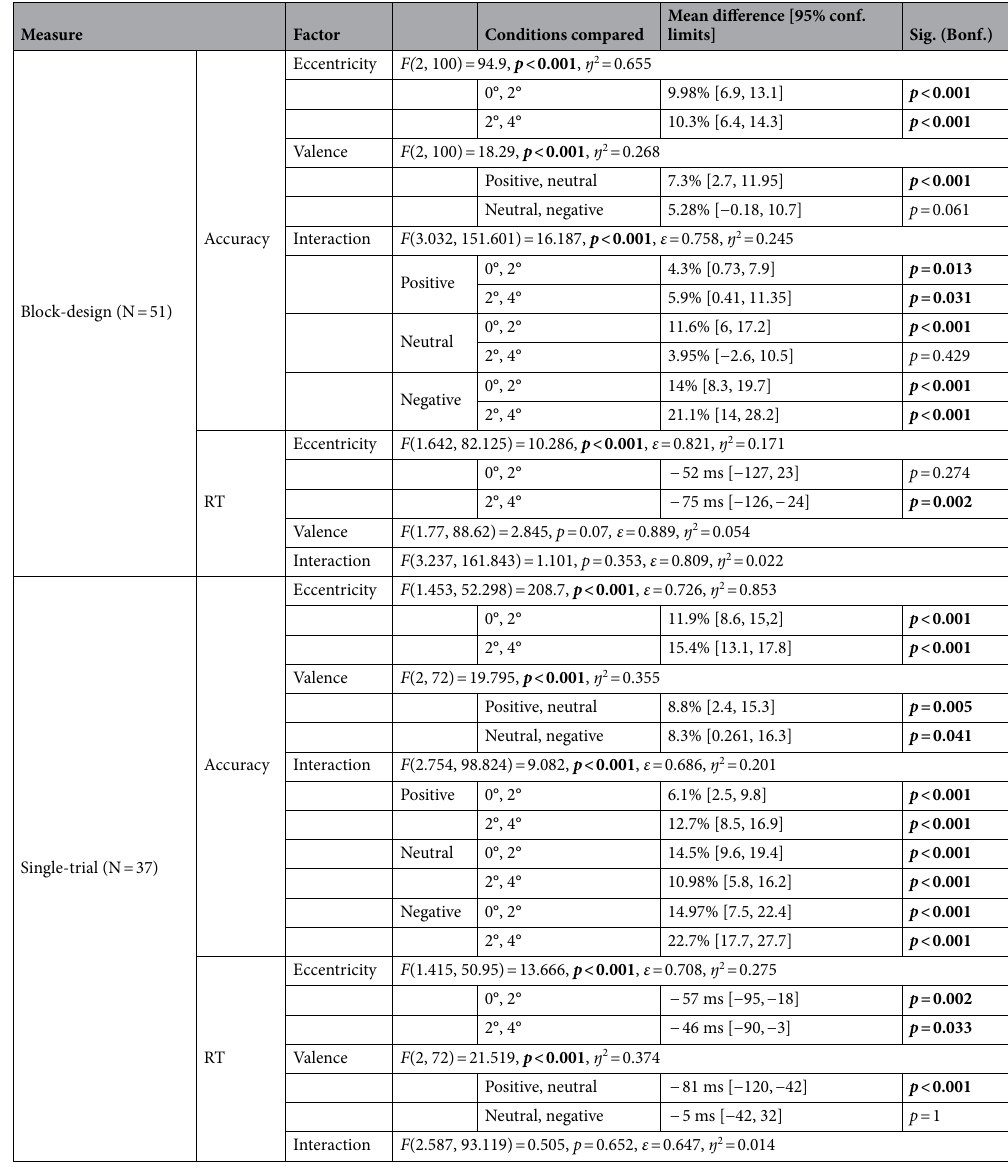
Table 2. Statistical analyses summary per experiment. For each experiment results of two 2-way repeated- measures ANOVAs (3 × 3) measuring the effects of eccentricity (0°, 2°, 4°) and valence (positive/neutral/ negative) on accuracy or RTs (post-hoc analyses based on Bonferroni corrections). Mean difference and 95% confidence interval [lower bound, upper bound] in Mean difference column. Significant results in bold. As can be seen significant effects of eccentricity and valence on accuracy were found in both experiments as well as a significant interaction between them). Eccentricity significantly affected RT in both experiments, but valence only in the single-trial experiment with faster responses for positive valence. See also Fig.